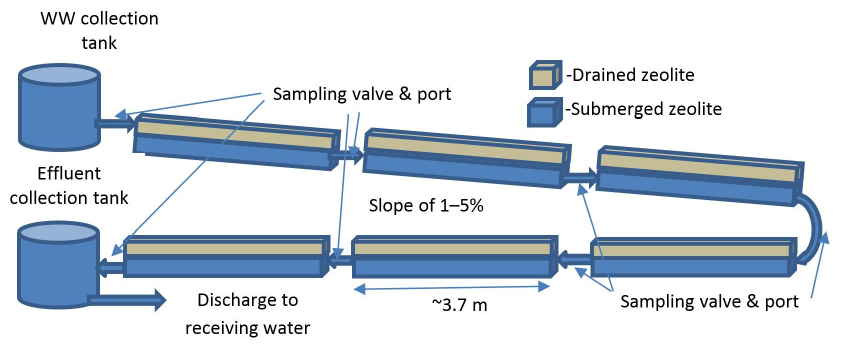
Figure 1. Schematic illustration of linear-channel reactors in pilot-plant trailers. Table 1. Zeolite properties—High purity (97%) clinoptilolite from Amargosa Valley,